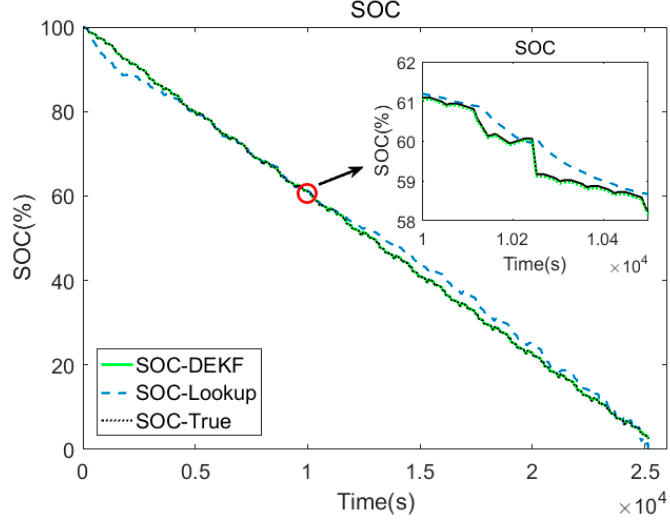
Figure 8. Comparison of SOC-DEKF, SOC-Lookup, and SOC-True.